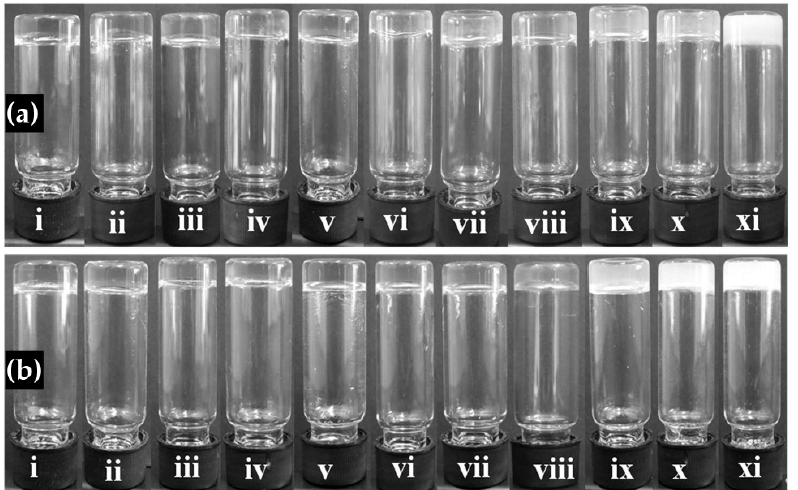
Figure 5. Photographs of gels formed by ( a ) cyclo(Tyr-Glu(O t Bu)) and ( b ) cyclo(Phe-Glu(O t Bu)) in various solvents: (i) toluene, (ii) chloroform, (iii) ethyl acetate, (iv) dichloromethane, (v) 1,2-dichlorbenzene, (vi) tert -butanol, (vii) sec -butanol, (viii) acetonitrile, (ix) 50% glycerol, (x) water, (xi) phosphate buffered saline (PBS, 10 mM, pH 7.4). Reproduced with permission from [113], copyright © 2017 American Chemical Society.